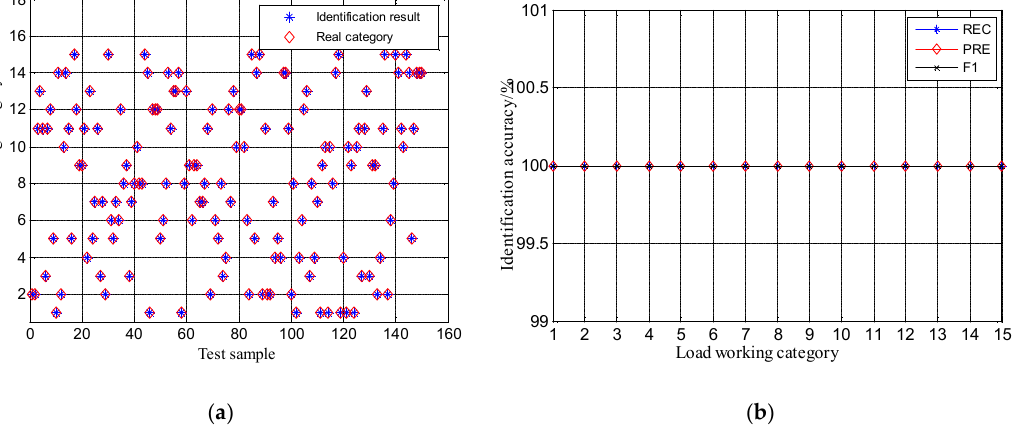
Figure 10. Identification results and accuracy of genetic algorithm optimized GRNN: ( a ) comparison between recognition results and actual categories; ( b ) identification accuracy.